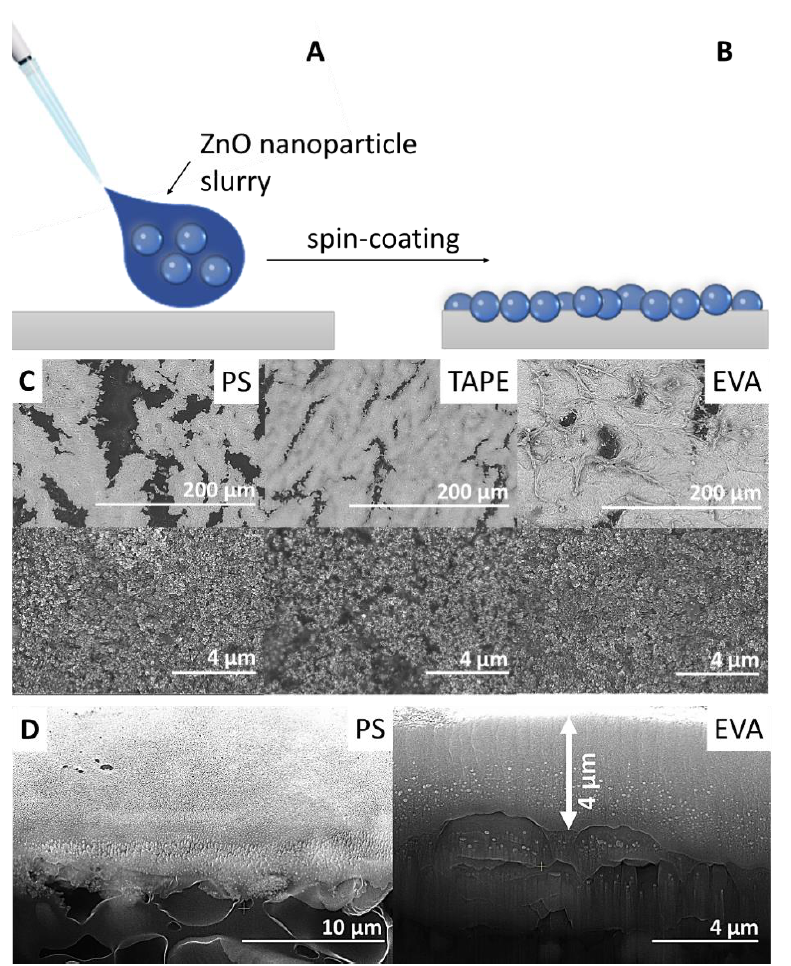
Figure 2. ZnO nanoparticles coating scheme: ( A ) ZnO nanoparticles slurry spin-coated onto the polymer surface, ( B ) obtained ZnO nanoparticles coating, ( C ) SEM images of ZnO nanoparticles coatings on polystyrene (PS), commercial acrylate tape and poly(ethylene-co-vinyl acetate) (EVA). ( D ) Cross-sectional SEM images of ZnO nanoparticles coatings on PS and EVA.